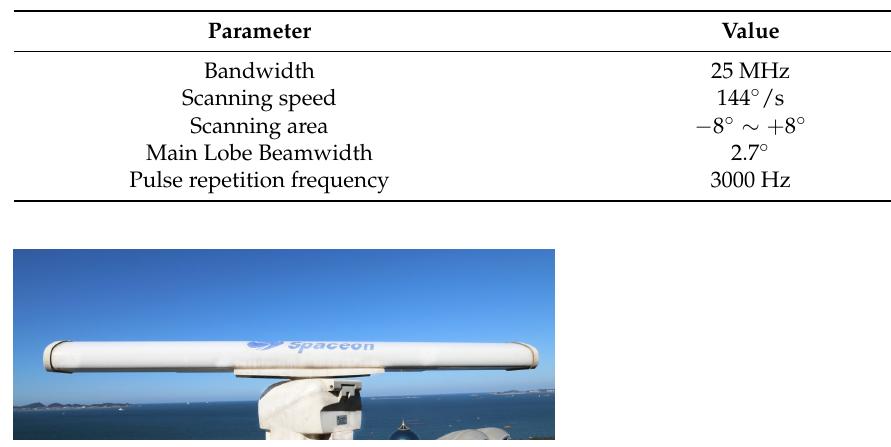
Table 4. System parameters of semi-real data.